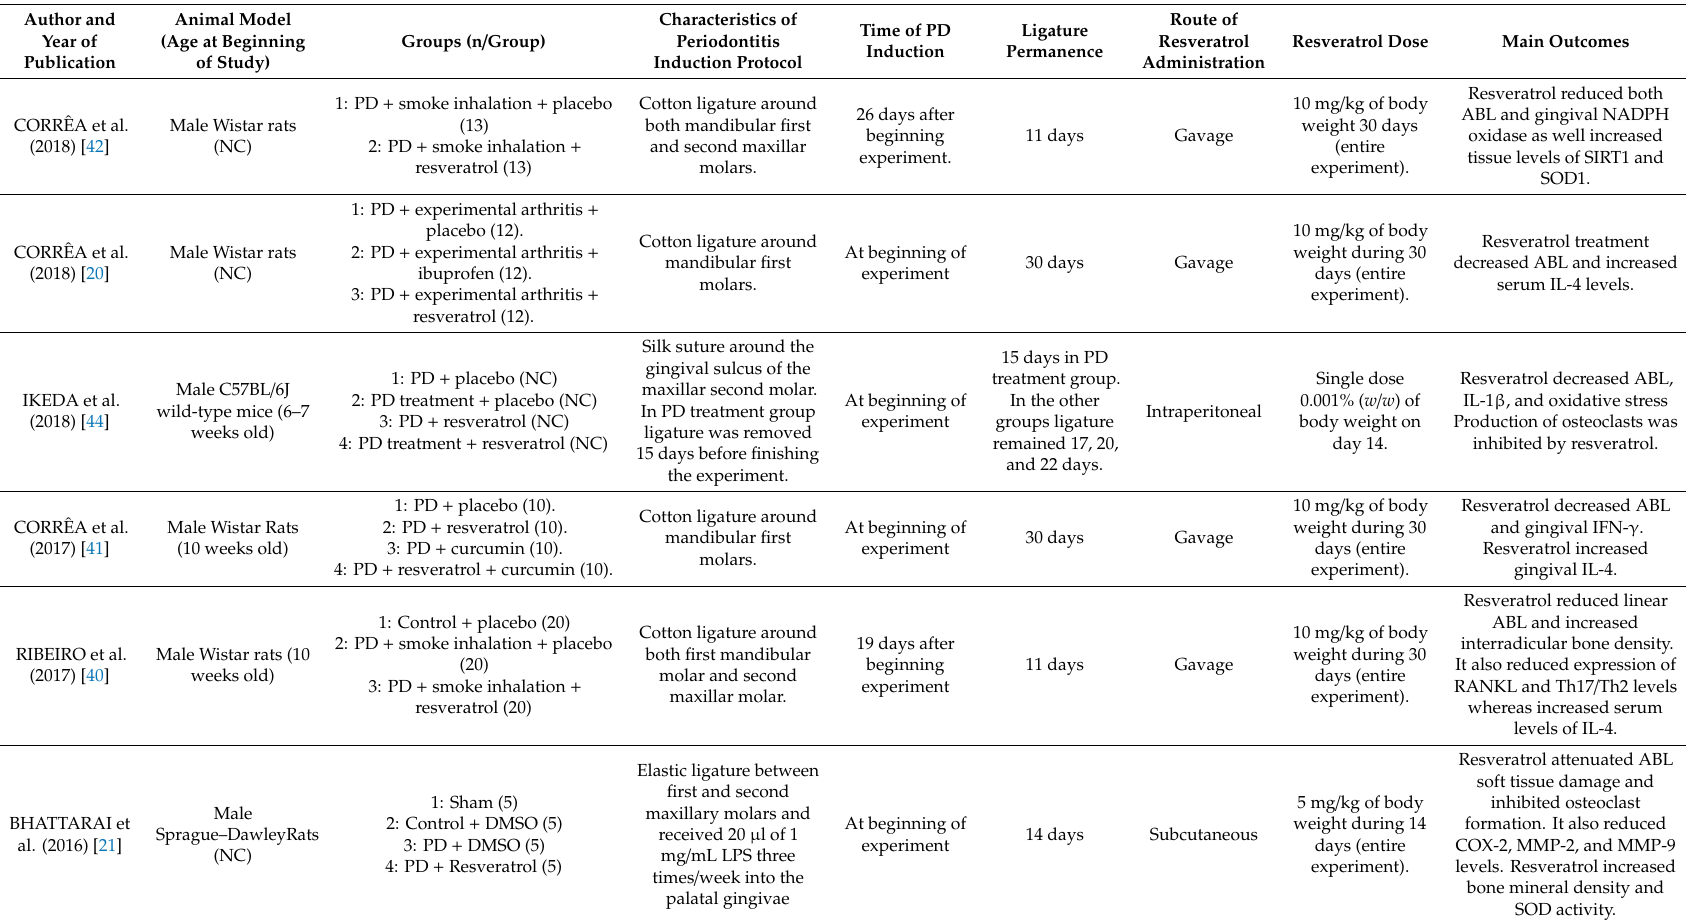
Table 1. The main features of the selected preclinical